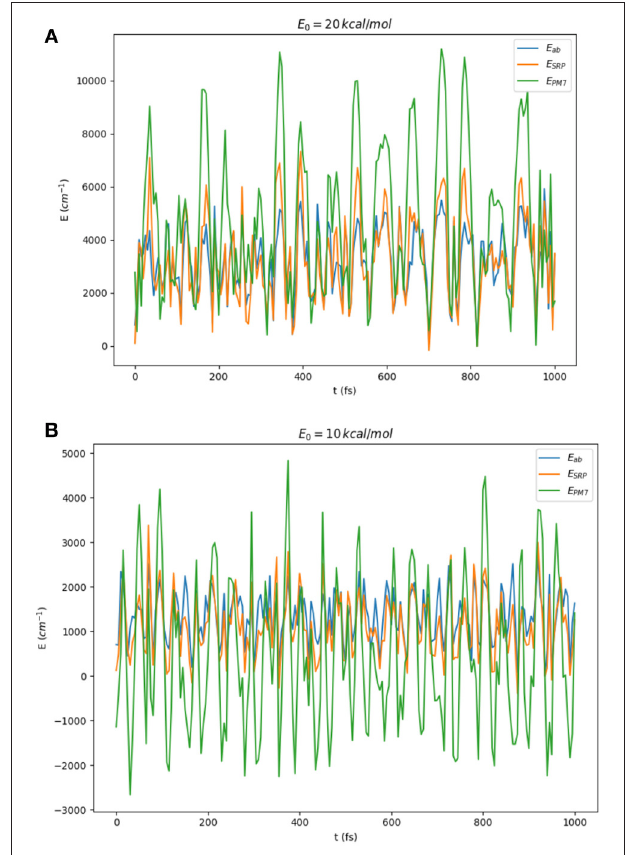
FIGURE 7 | Comparison of ab initio (blue line), PM7 (green line), and SRP-PES ( ζ 1084 ) (orange line) energies for the geometries generated in classical on-the-fly trajectories of HONO(6D) with total energies (randomly distributed among all modes) of 10 and 20 kcal/mol starting at: (A) the trans -conformer and (B) the cis -conformer. FIGURE 8 | Definition of the internal coordinates of HONO used in this